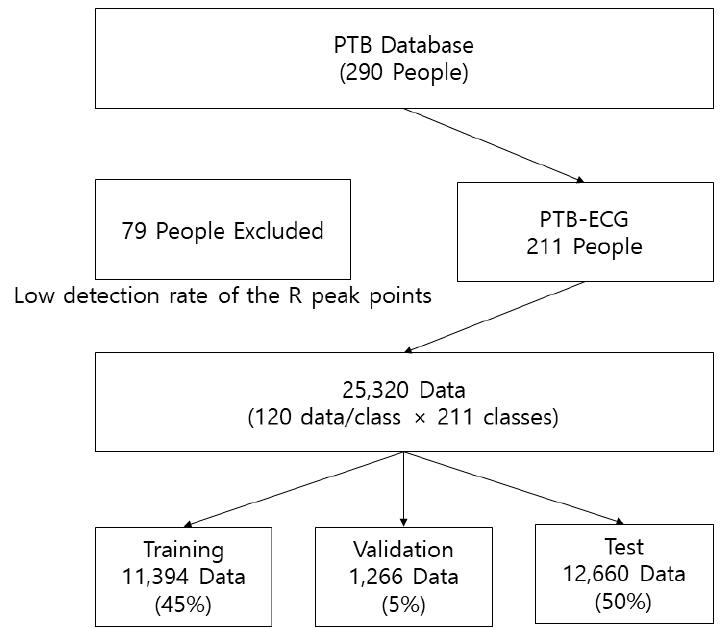
Figure 11. Structure of Physikalisch-Technische Bundesanstalt (PTB)-ECG employed in this study. Table 1. Accuracies achieved by PCA-L2 using time-frequency representations on PTB-ECG. Input